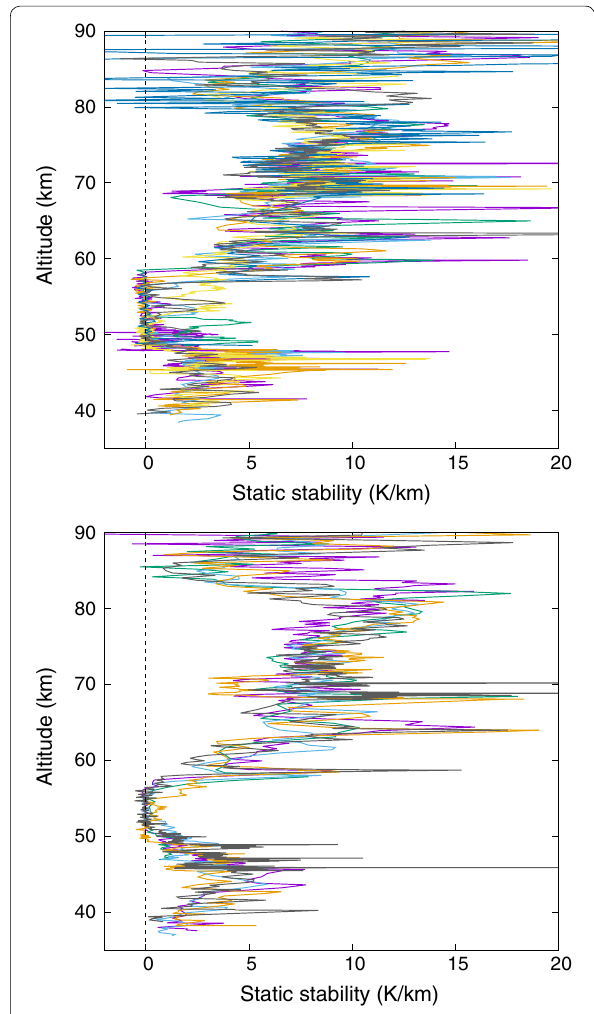
Fig. 7 Static stability profiles in the latitude of 40°S–40°N on the (upper) morning side with local times of 01:10–07:10 and (lower) afternoon side with local times of